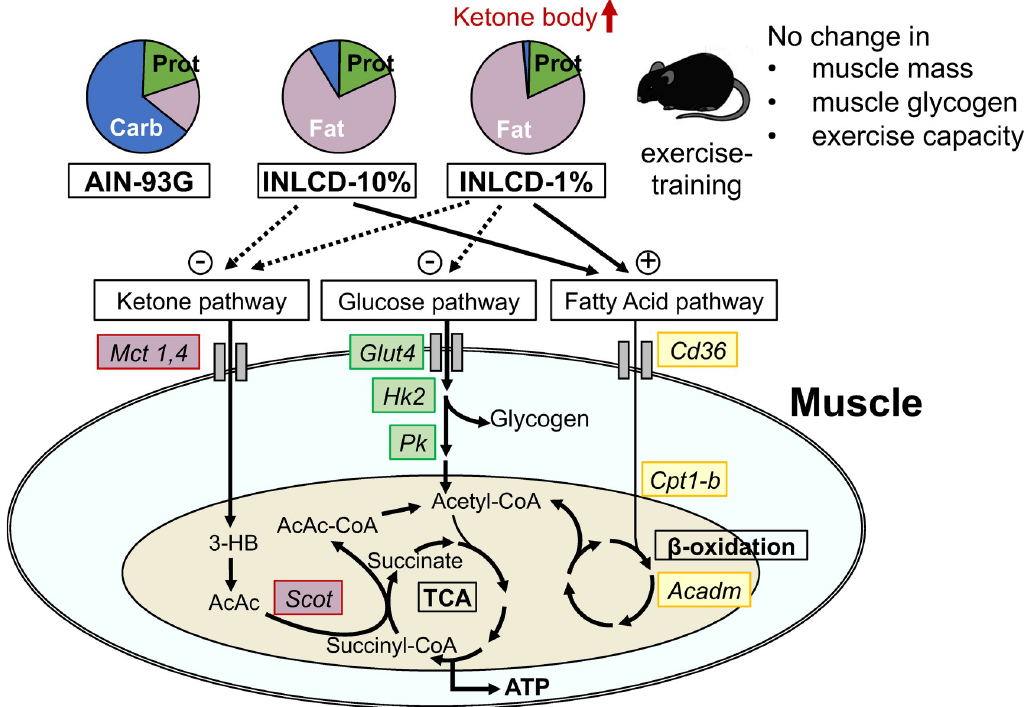
Fig 6. The effects of isonitrogenous INLCDs on exercise-trained mice. Carb; carbohydrate, Prot; protein, Mct ; monocarboxylic acid transporter, Glut4 ; glucose transporter 4, Hk2 ; hexokinase 2, Pk ; pyruvate kinase, Cd36 ; cluster of differentiation 36, Cpt1b ; carnitine palmitoyltransferase 1b, Acadm ; medium-chain acyl-CoA dehydrogenase, Scot ; succinyl-CoA 3-oxoacid CoA transferase, 3-HB; 3-hydroxybutyrate, AcAc; acetoacetic acid.